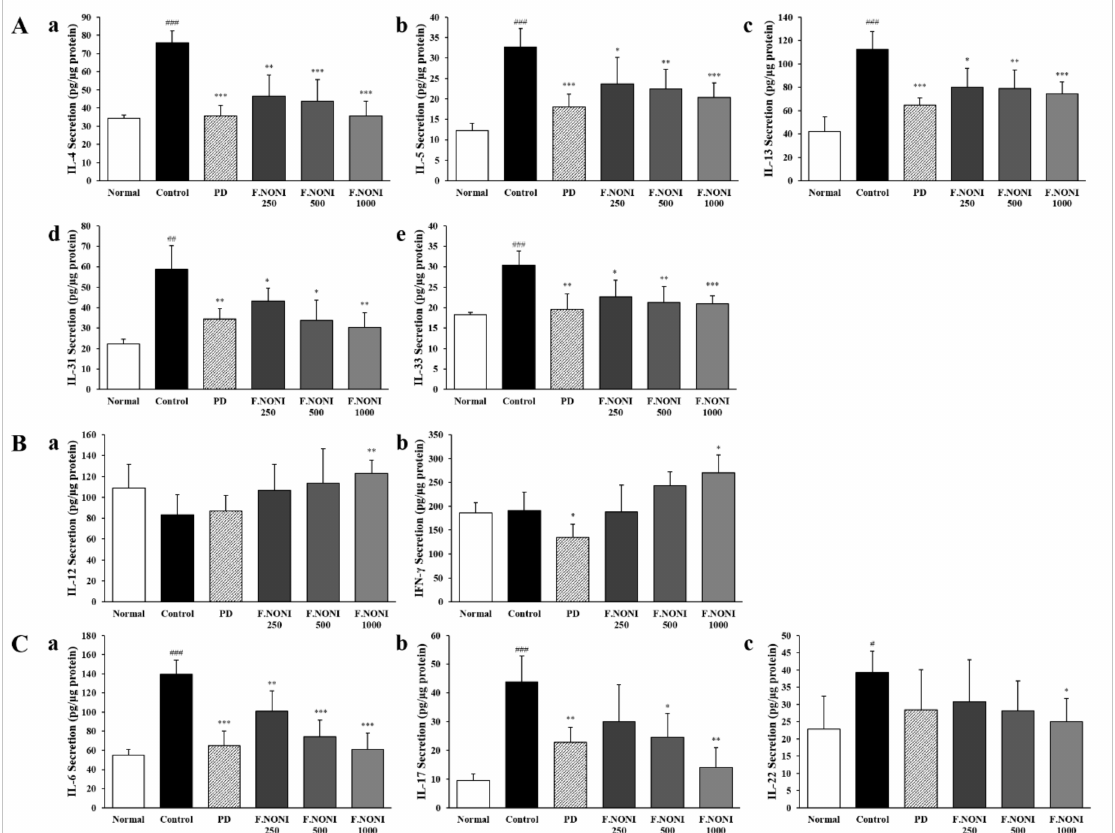
Figure 5. E ff ect of F.NONI on AD-related cytokine secretion in the splenocytes of AD-induced NC / Nga mice. ( A ) Levels of ( a ) IL-4, ( b ) IL-5, ( c ) IL-13, ( d ) IL-31, and ( e ) IL-33 in the supernatant of splenocytes. ( B ) Levels of ( a ) IL-12 and ( b ) IFN- γ in the supernatant of splenocytes. ( C ) Levels of ( a ) IL-6, ( b ) IL-17, and ( c ) IL-22 in the supernatant of splenocytes. The splenocytes of NC / Nga mice were obtained on the last day of the experiment and responded to in vitro. Con-A stimulation for 72 h, then supernatant was measured using ELISA. The results were presented as mean ± SEM ( n = 5). # p < 0.05, ## p < 0.01, ### p < 0.001 vs. normal, * p < 0.05, ** p < 0.01, *** p < 0.001 vs. control. Normal, untreated group; Control, atopic dermatitis induced by DNCB; PD, positive control (prednisolone 3 mg / kg) treated group; F.NONI (fermented Morinda citrifolia 250, 500, or 1000 mg / kg) treated